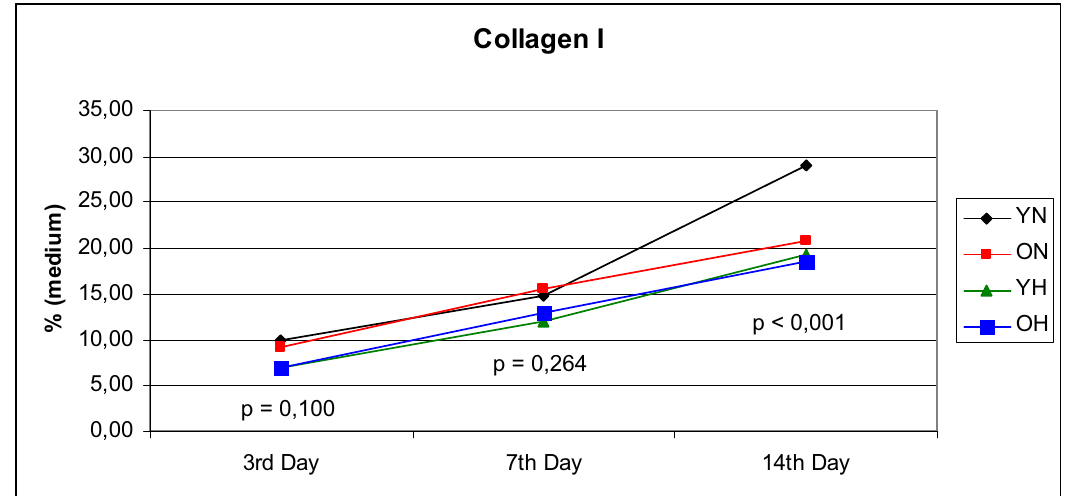
FIGURE 5 – Curve showing gain in collagen I density in the anastomoses of the four